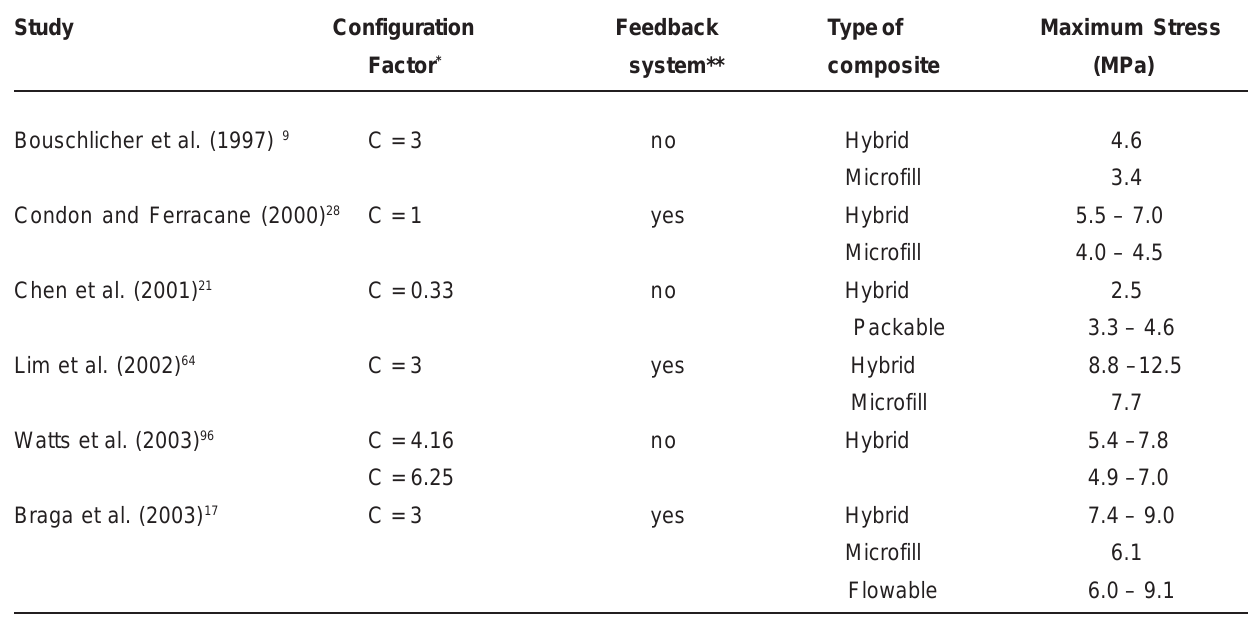
*ratio of bonded to unbonded surfaces of the composite **indicates the use of a near-zero compliance